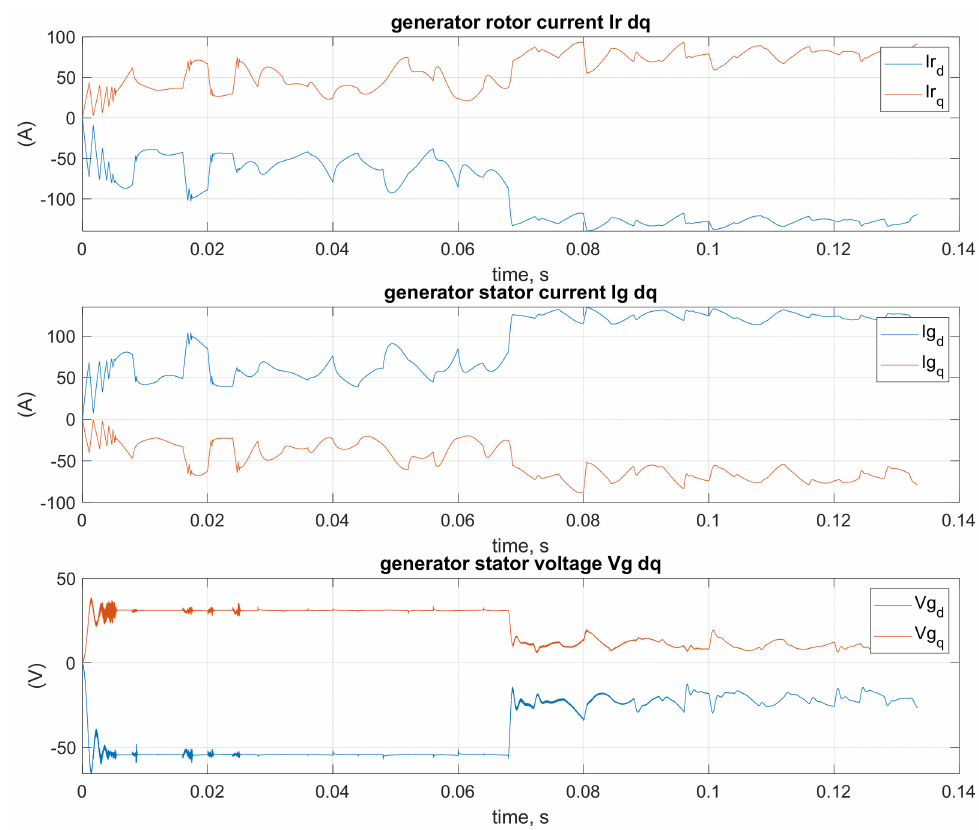
Figure 20. Stator voltage V g , stator current I g and rotor current I r in the dq coordinate system, with limitations on control values, when the system does not provide appropriate voltage due to overload.